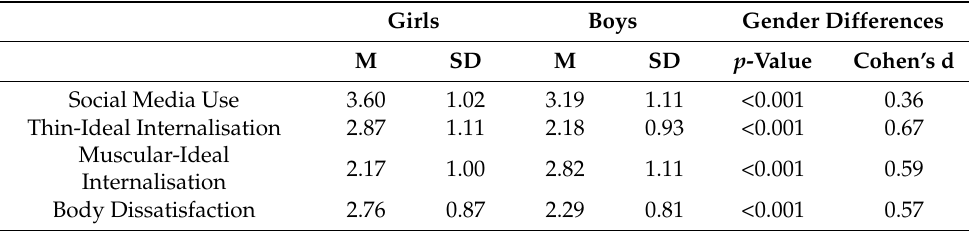
Table 1. Means (M), Standard Deviations (SD) and Gender Differences in Social Media and Body Image Variables.